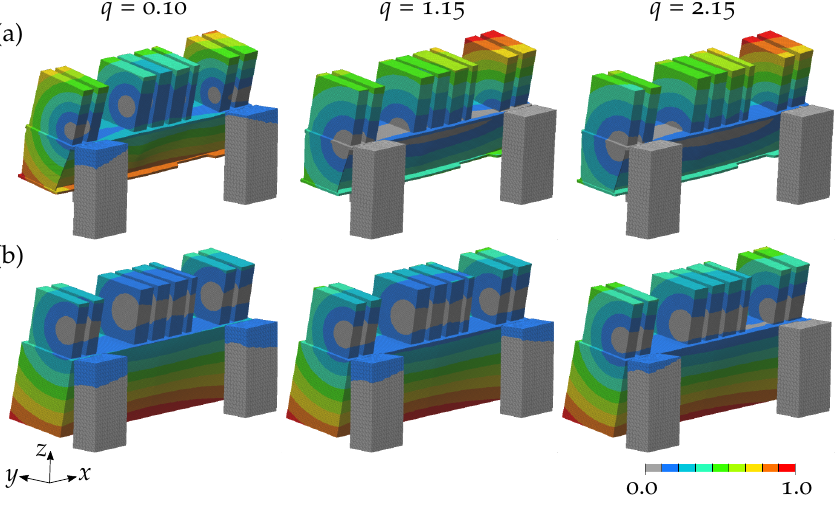
Figure 20. First mode shape of the magnet–girder assembly with the PETRA III girder ( a ) and the box girder ( b ) depending on different magnet masses that were generated by multiplying the mass of each magnet with the factor q . The colours represent the normalised vibration